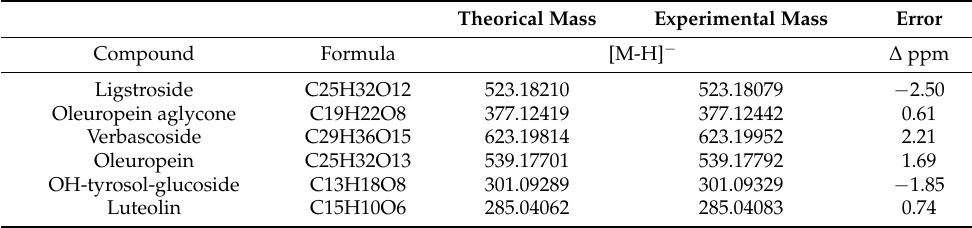
Table 2. Exact mass spectra data (molecular formula, deprotonated molecular ion ([M-H] − ) and